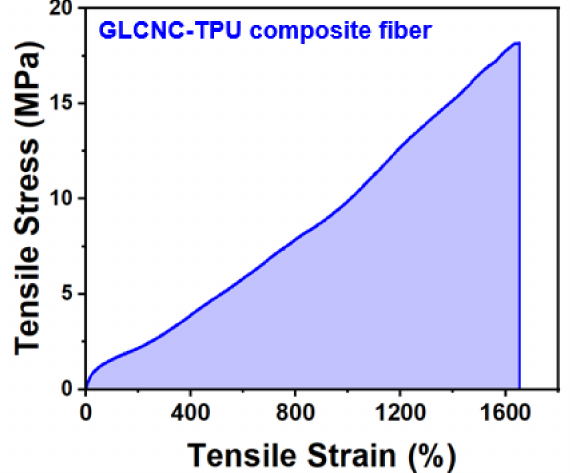
Figure 10. Stress–strain curve of GLCNC-TPU composite